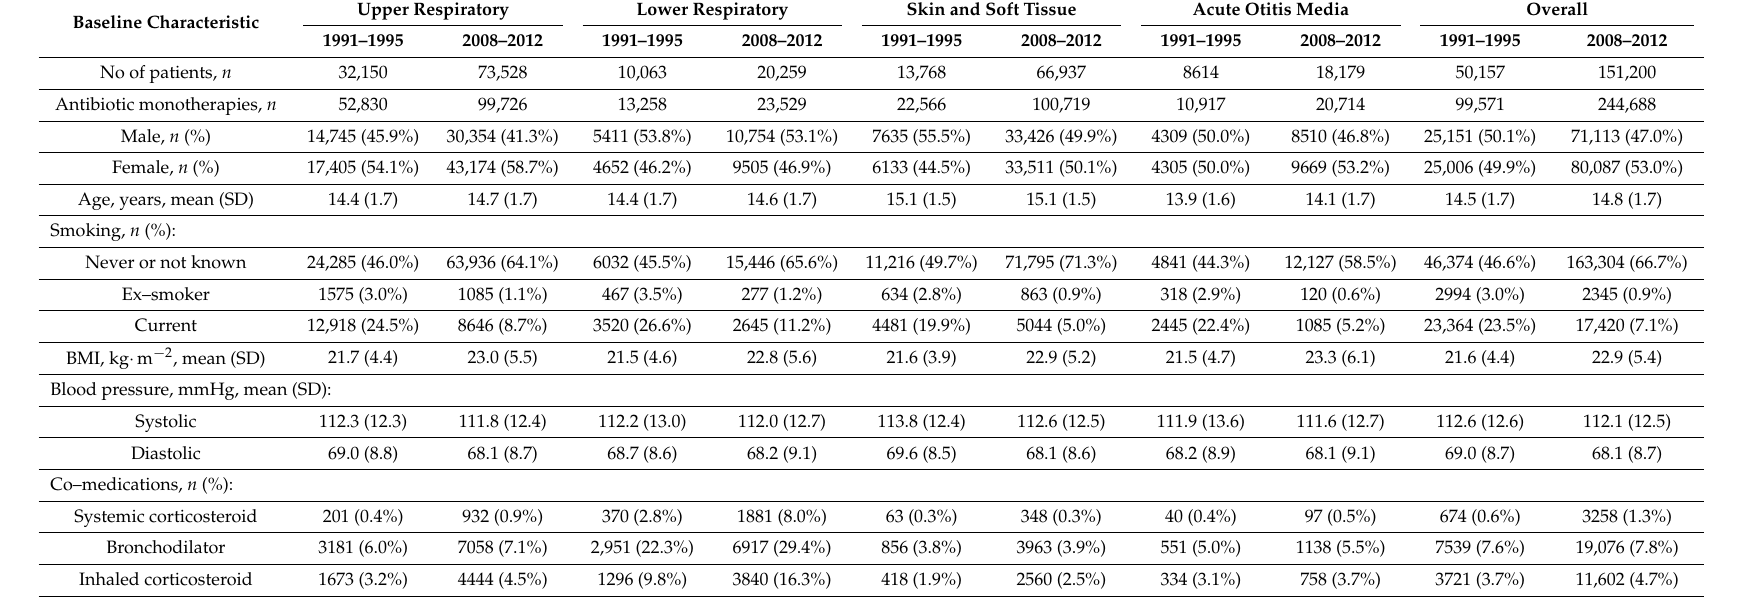
Table 1. Baseline characteristics by infection class and by early and late time